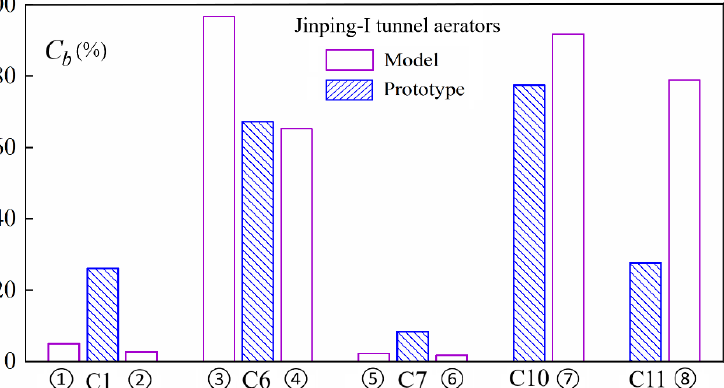
Figure 14. Jinping-I tunnel aerators, model–prototype comparisons of chute bottom air concentration Figure 14. Jinping ‐ I tunnel aerators, model–prototype comparisons of chute bottom air concentra ‐ C b (adapted from [15]). Points 1 (cid:13) – 8 (cid:13) are model measurement points in the vicinity of their respective tion C b (adapted from [15]). Points ① – ⑧ are model measurement points in the vicinity of their respective prototype locations. prototype locations.